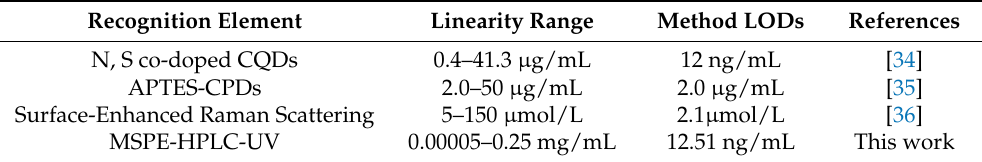
Table 3. A comparison between this work and other reported works.